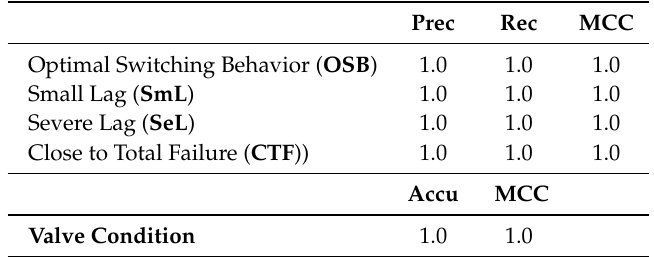
Table 5. Classification results for the Valve condition at the state and multiclass classifier level.